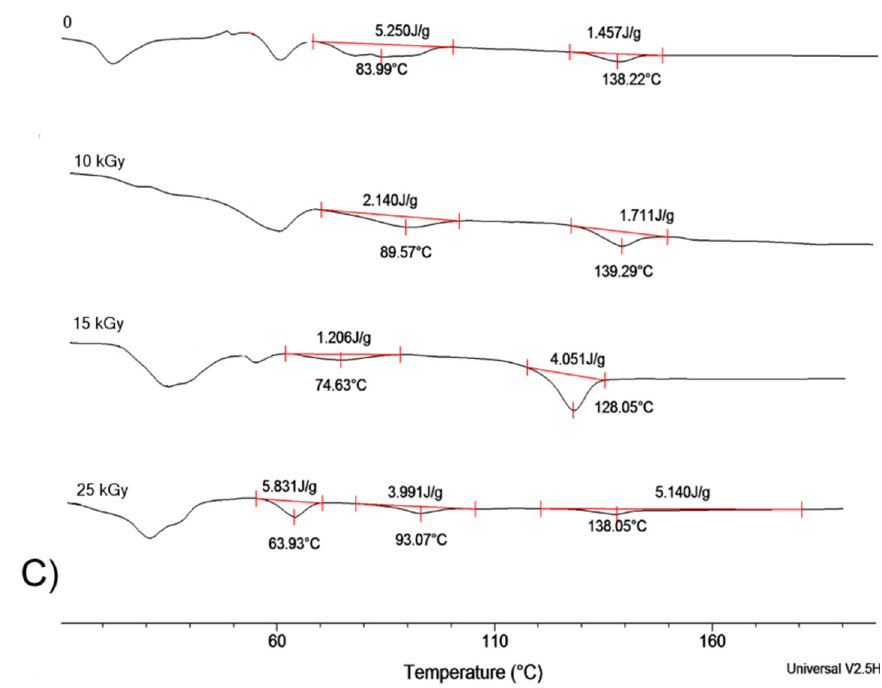
Figure 4. DSC trace for copolymer ( A ) LGT21 C; ( B ) LGT40 C; and ( C ) LGC C. I-heating run at 20 °C/min after electron beam irradiation with dose: 0 kGy, 10 kGy, 15 kGy, and 25 kGy.